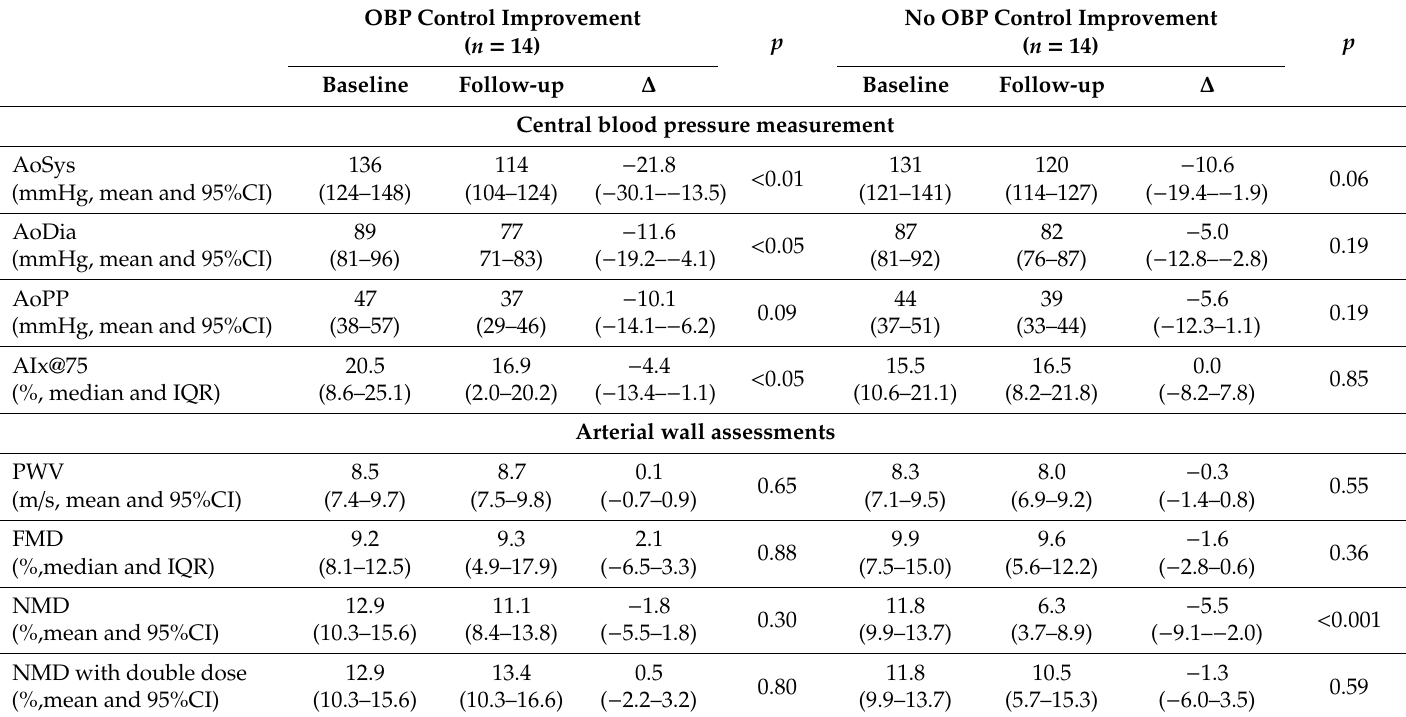
Table 3. The central blood pressure parameters and the measurements of arterial sti ff ness (pulse wave velocity (PWV)) and endothelial function (flow-mediated dilation, (FMD) and nitroglycerine-mediated dilation (NMD)) measured before and after successful DAA treatment in kidney transplant recipients in both study subgroups, based on changes in OBP control after